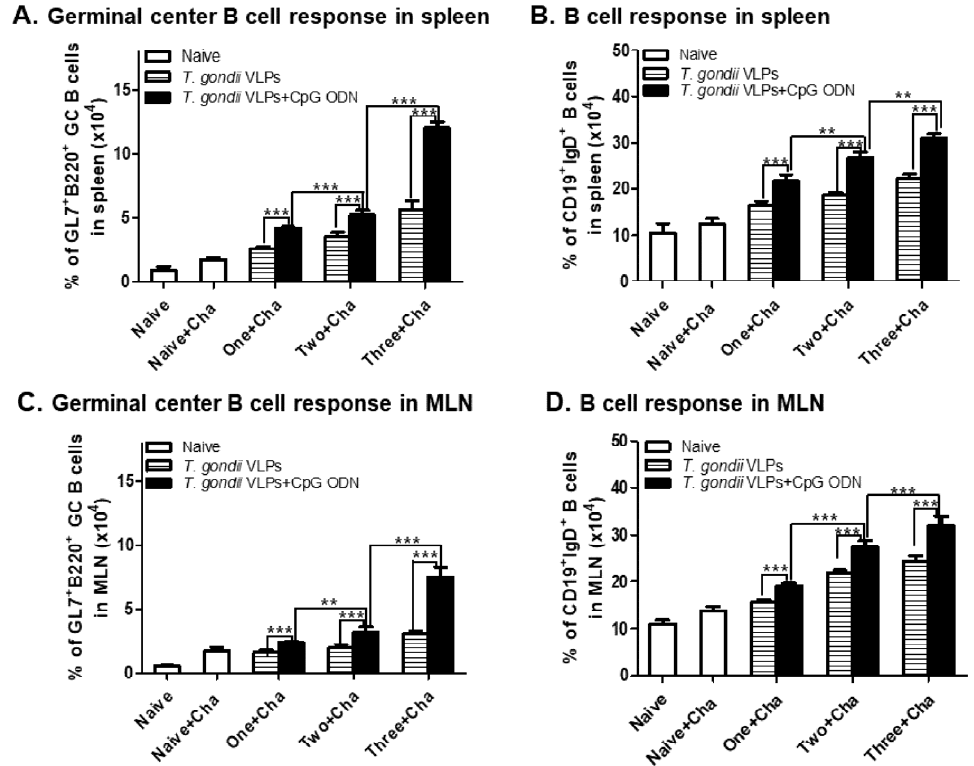
Figure 5. Immunization with the adjuvanted T. gondii VLPs enhances antigen-specific B-cell responses. Immunized mice ( n = 6 per group) were infected with T. gondii ME49, 4 weeks after the last immunization. Spleen and MLN tissues were harvested at 35 dpi and then cell phenotypes were determined by flow cytometry. The percentage of GC B ( A , C ) cells or B cells ( B , D ) was quantified by subtracting unstimulated cells from stimulated cells. Results are presented as mean ± SD and statistical significances were denoted using asterisks (** p < 0.01 and *** p < 0.001).